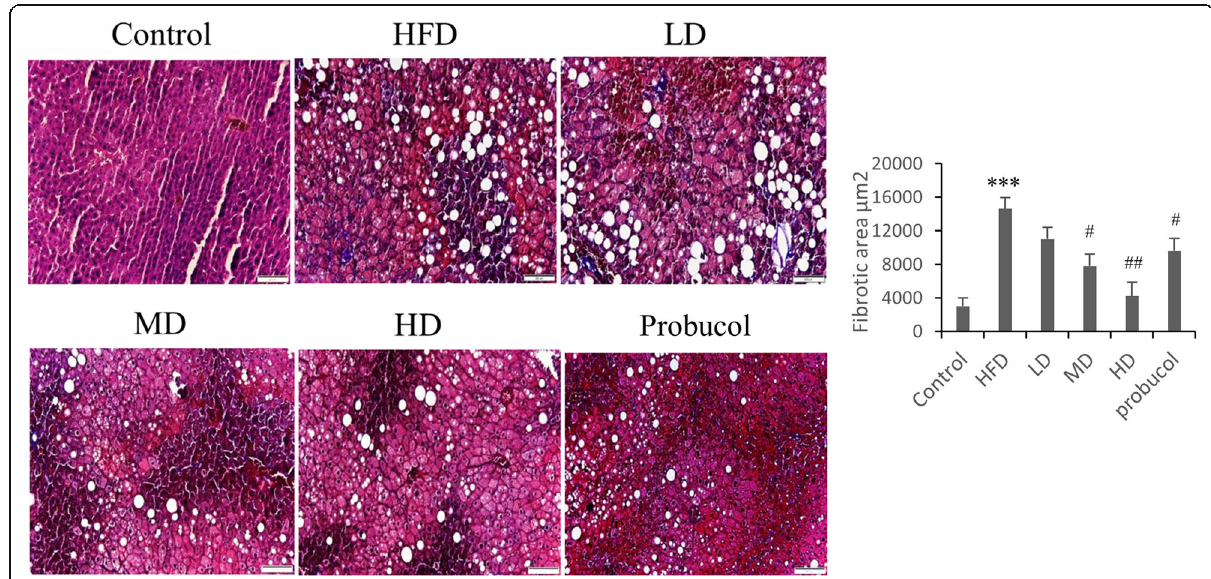
Fig. 2 Effect of APPH on hepatic fibrosis: Masson ’ s trichrome staining show the levels of collagen accumulation in HFD and the APPH treated hamsters in Control hamsters, HFD fed hamsters (HFD), HFD fed hamsters treated with low dose of APPH (L-APPH), HFD fed hamsters treated with moderate dose of APPH (M-APPH), HFD fed hamsters treated with high dose of APPH (H-APPH) and HFD fed hamsters treated with probucol. n = 3, *** p < 0.001 when compared with the Control group; # p < 0.05 and ## p < 0.01 when compared with HFD group